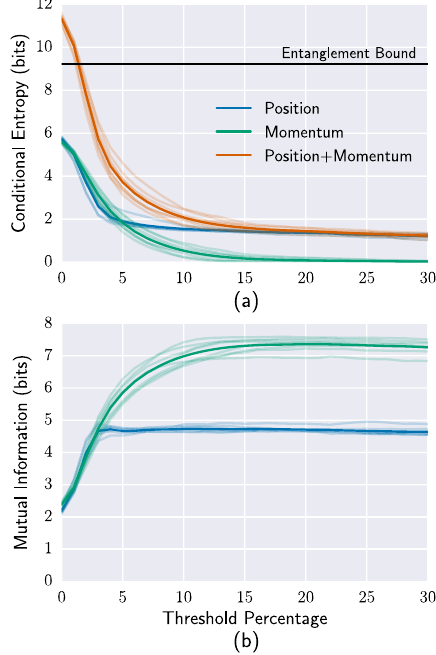
FIG. 6. Effect of thresholding. The effect of thresholding to remove weak background noise on the conditional entropy (a) and mutual information (b) is given. The bold line gives the average for nine trials; faded lines give the results from the individual trials. M ¼ 4439 measurements were used. When the conditional entropy sum is below the bound, the state is